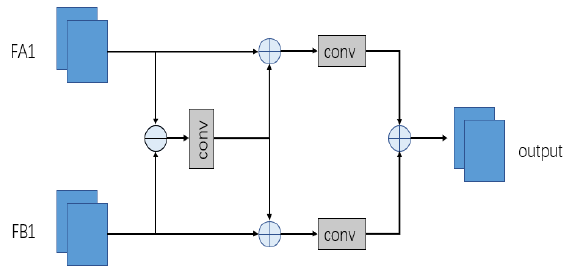
7 of 18 Figure 3. Structure of the MSCB. 2.4. Feature Fusion Module